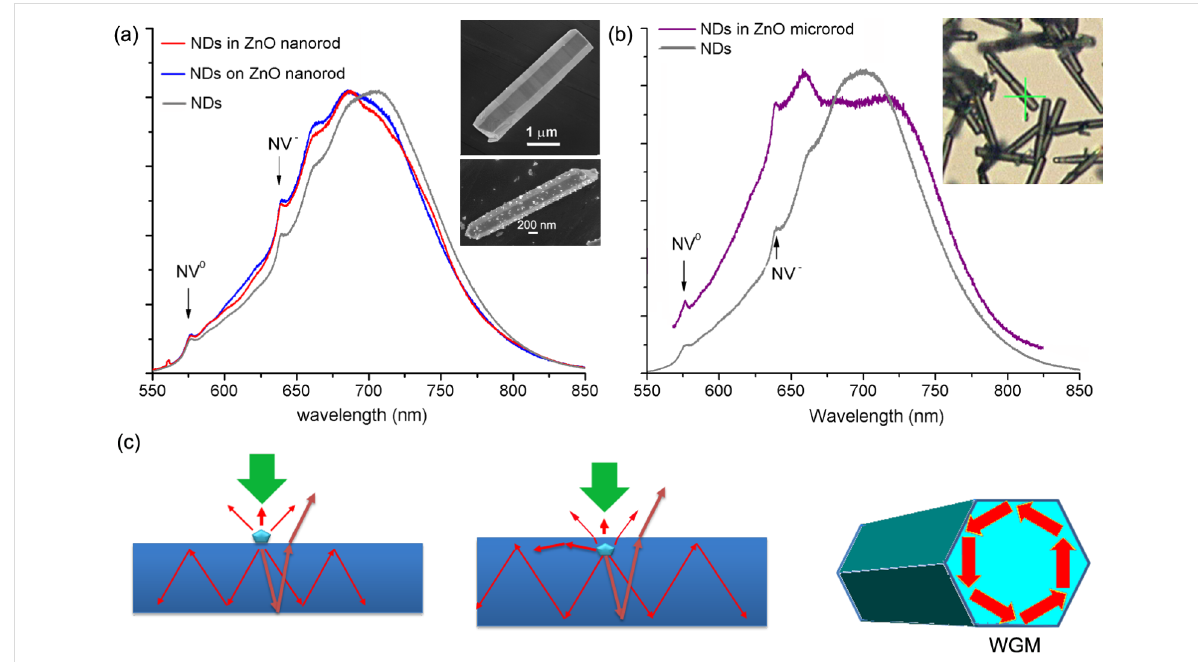
Figure 6: (a) Micro-PL spectra taken from a single ZnO nanorod containing NDs, a nanorod with NDs in the surface, and cluster of naked NDs, res- pectively. The insets show typical SEM images of two fractured ZnO nanorods lying on bare Si. One nanorod contains NDs and the other one has NDs attached to its surface. (b) Micro-PL spectra of a single ZnO microrod containing NDs and naked NDs. The inset shows an optical photograph taken during the PL measurement. The relatively thick rod marked by a cross was targeted for PL measurement. (c) Illustrations for light propaga- tions when the emission from a ND interacts with the rod